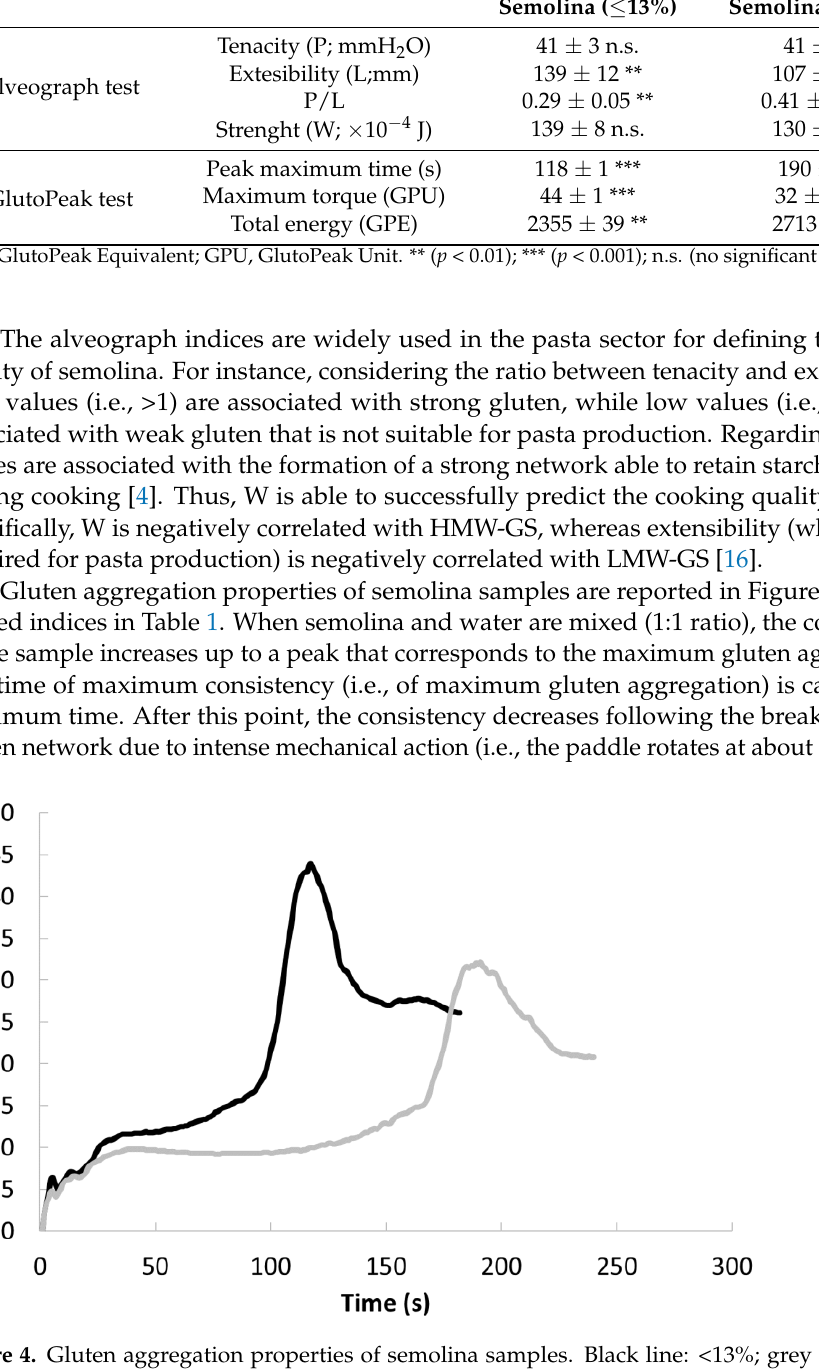
Figure 4. Gluten aggregation properties of semolina samples. Black line: <13%; grey line: >13%. GPU, GlutoPeak Unit.